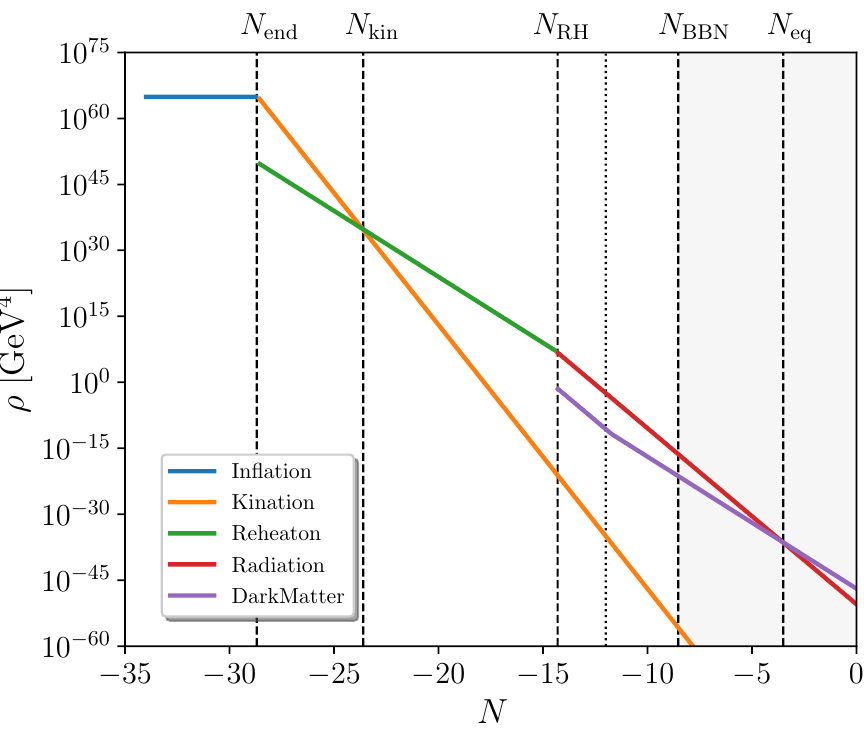
Figure 1 . Evolution of the different components present in the Universe along the cosmologi- cal history. The vertical dotted line stands for the time where DM becomes non-relativistic.The parameters used in the figure are η = 10 − 15 , m S = 1 GeV , m DM = 1 MeV , Γ S = 10 − 15 GeV , and w kin = 1 . In the x -axis, N = ln( a ) stands for the number of e -folds before present